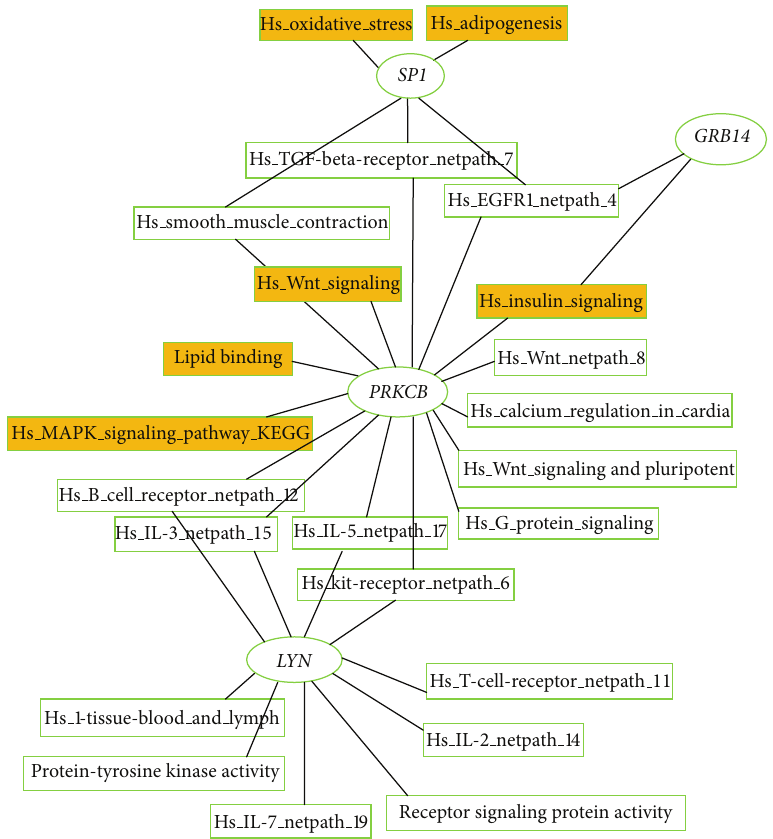
Figure 2: Enrichment analysis of GO and pathways for all genes. Yellow represents pathway directly or indirectly related to T2DM or obesity.